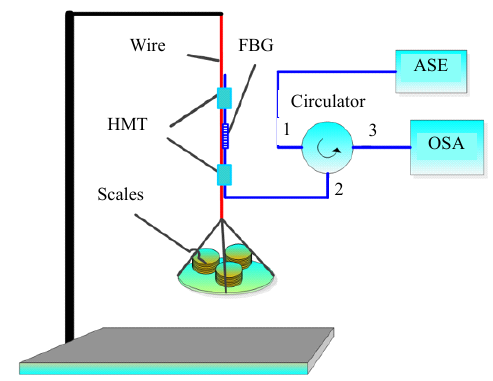
Fig. 1 Experimental setup of Young’s modulus measurement based on